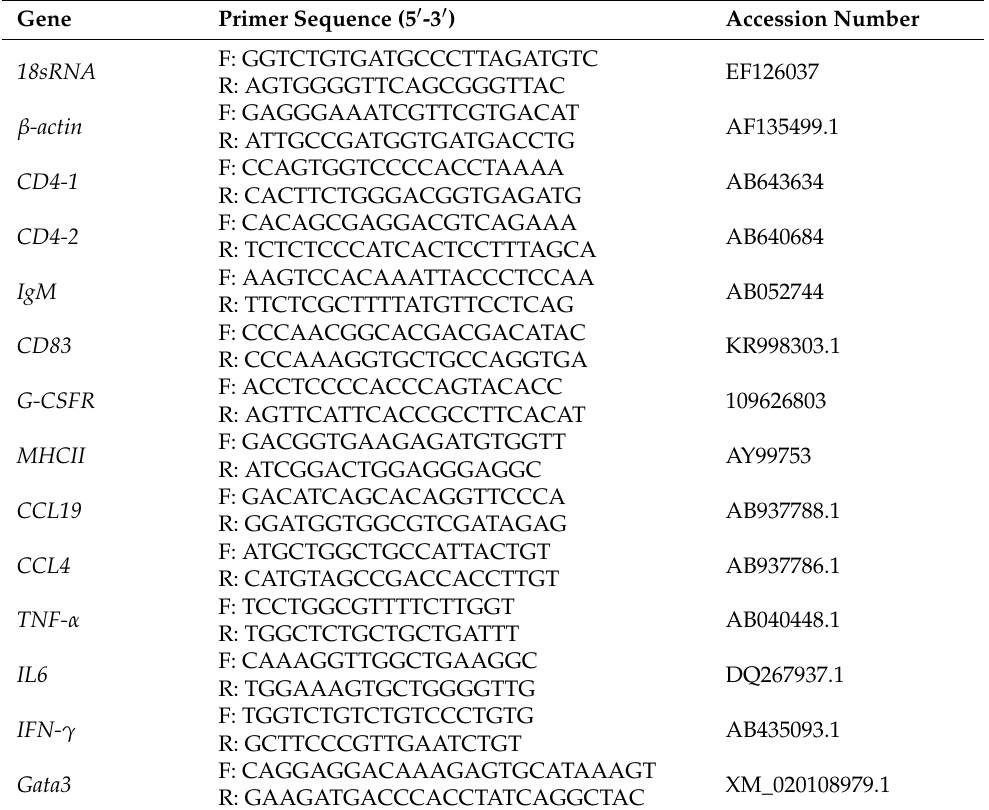
Table 1. Primers used in the present